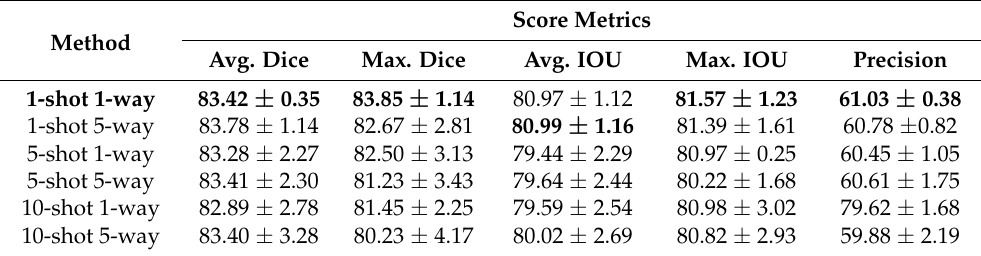
Table 3. Results of (1, 5, 10)-shot (1, 5)-way segmentation on the BraTS 2021 dataset using mean and maximum dice and IoU metrics (in percentage). Scores are obtained from the validation of 250 randomly sampled volume